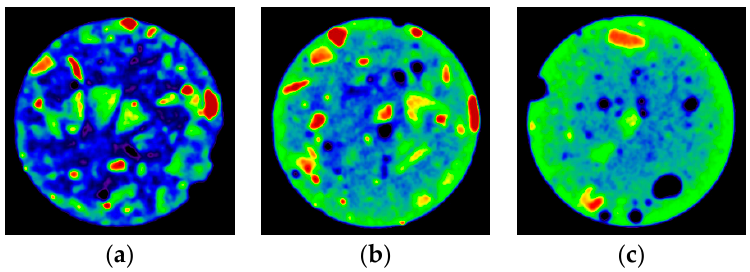
Figure 10. Initial CT image of the mixed disposal body at different waste rock contents. ( a ) The waste rock of 50%; ( b ) the waste rock of 30%; and ( c ) the waste rock of 10%.